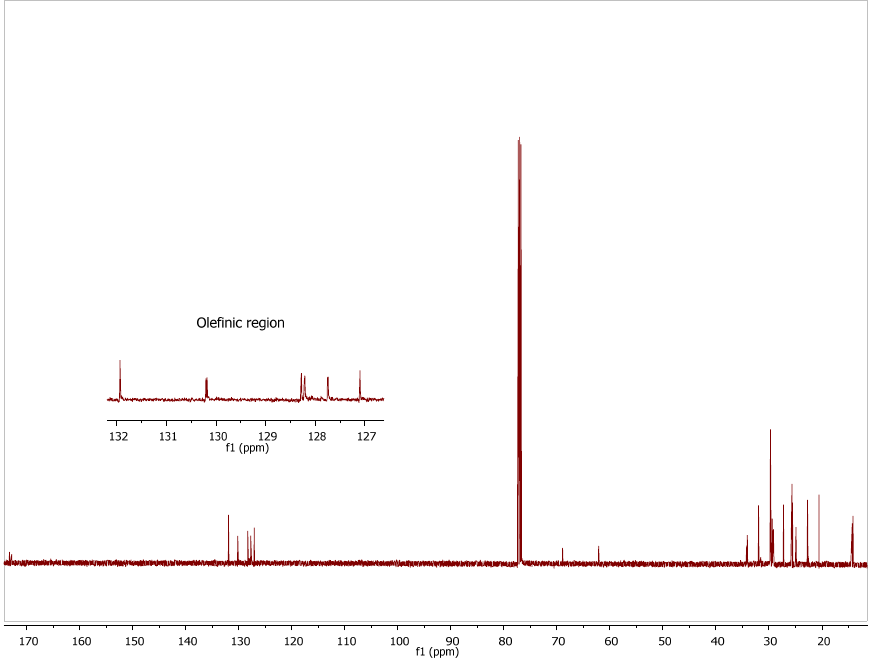
Figure 3. The 13 C-NMR spectrum of the crude DCM extracted from gorse flowers. To confirm this observation and to determine the fatty acid profile, the corresponding methyl esters were prepared. The crude triglyceride mixture was reacted in methanol with a catalytic amount of sulphuric acid (98%) at reflux for 5 h, which yielded a green, oily product of fatty acid methyl ester. The reaction was judged to have reached completion by TLC ( Rf of starting oil: 0.47, Rf of product: 0.66, petrol/ethyl acetate, 10:1). By comparing the retention times with those of the standards, GCMS showed linolenic acid as the dominant fatty acid of the mixture and thereby confirmed the observation in 13 C-NMR (Figure 4 and Table 1). The results of GCMS are presented in Table 1.